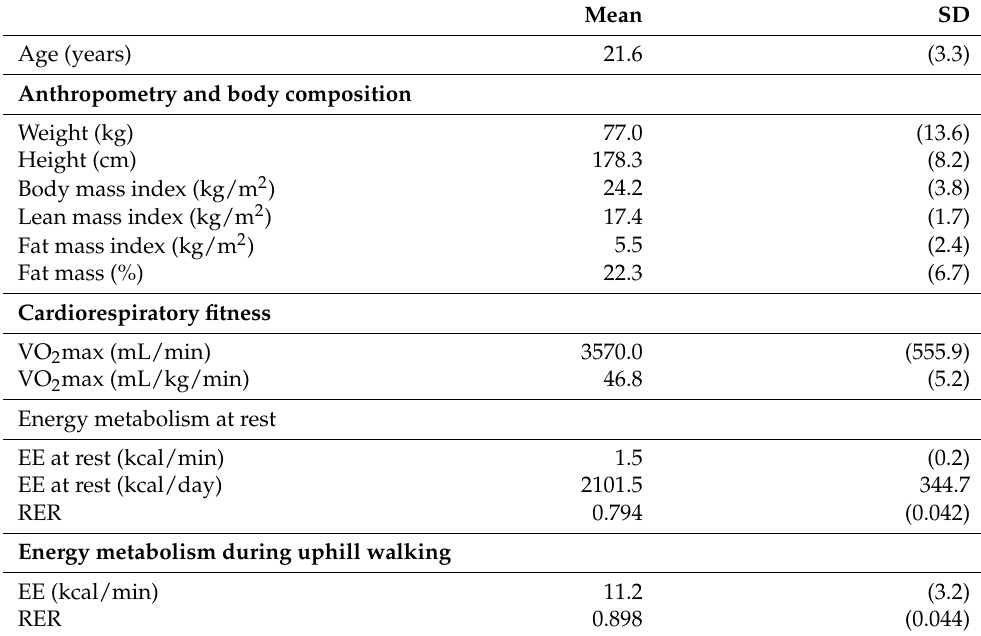
Table 1. Descriptive characteristics of the study